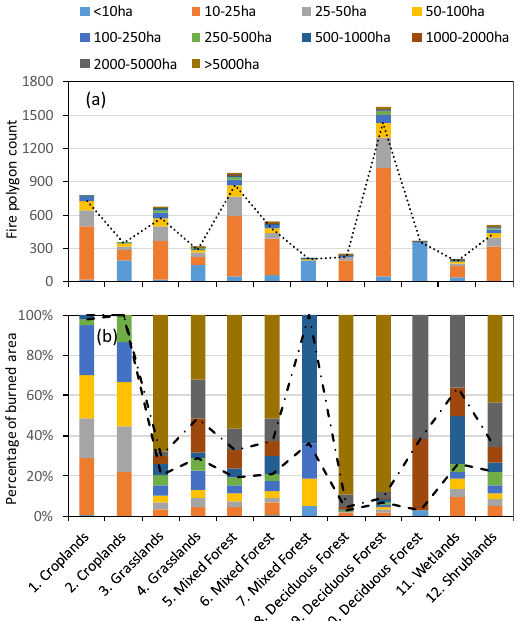
Figure 2. Fire occurrence in the reference satellite products as a function of fire size shown by ( a ) fire polygon count and ( b ) percentage of burned area in the region (burned area fraction). Dotted line in ( a ) indicates the boundary of fire counts for fires of 100 ha. Dashed and dashed–dotted lines in ( b ) indicate the boundaries of burned area percentage for fires of 500 and 2000 ha,